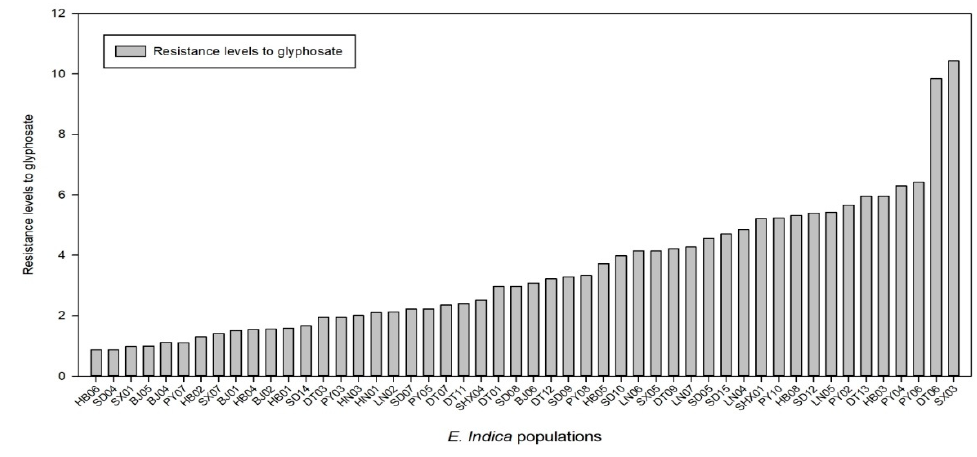
Figure 2. Glyphosate resistance level of different E. indica accessions from farmland around Dongting (DT) and Poyang (PY) lakes, apple orchards around areas of Bohai Rim (Beijing, BJ; Hebei, HB; Liaoning, LN; Shandong, SD) and Loess Plateau (Henan, HN; Shanxi, SX; Shannxi, SHX) in China. Table 1. Shikimate accumulation in E. indica leaves treated by glyphosate at concentrations of 1.0, 10 and 100 mg/L. Data were sorted from largest to smallest according the shikimic acid concentration treated by 100 mg/L